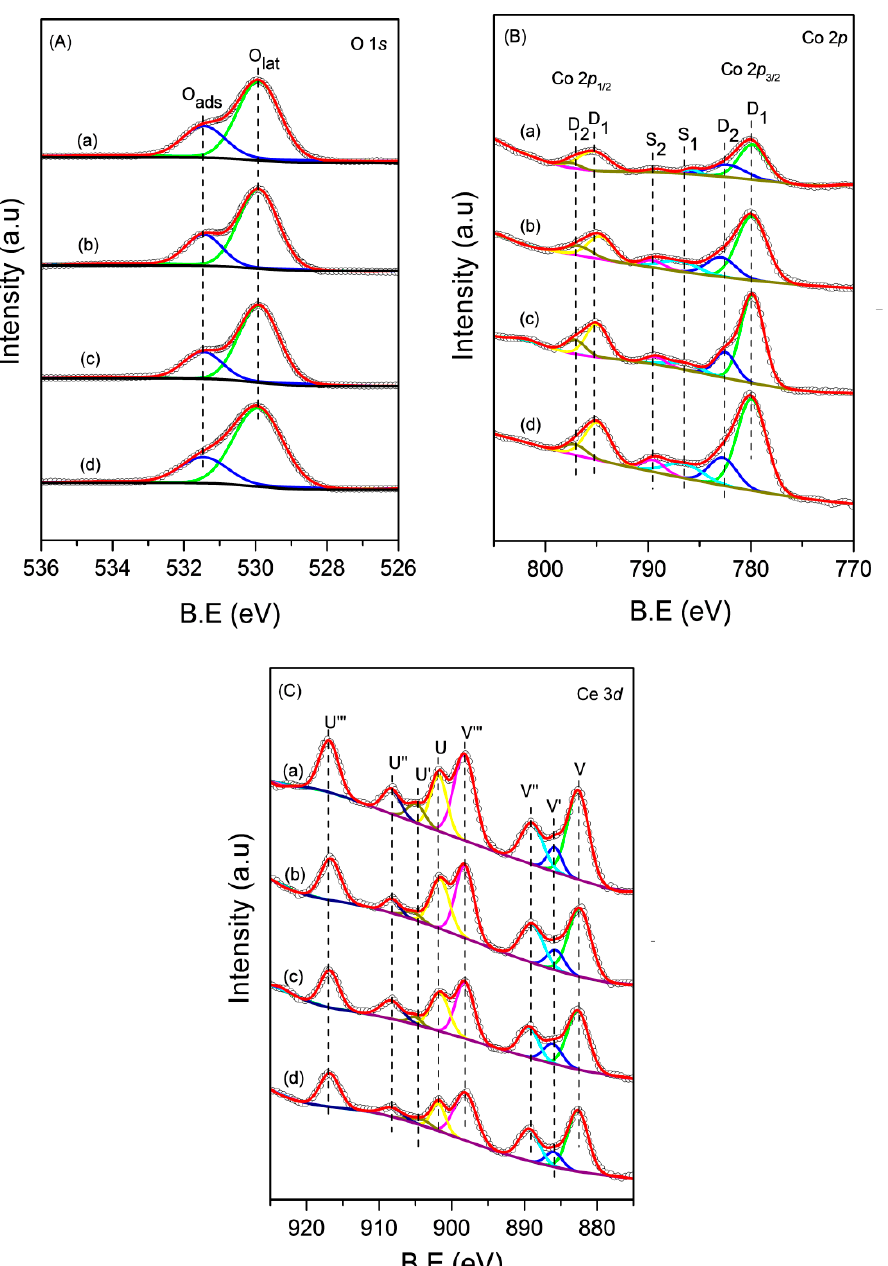
Figure 5. Experimental and fitted: ( A ) O 1 s ; ( B ) Co 2 p ; and ( C ) Ce 3 d photoelectron spectra of the